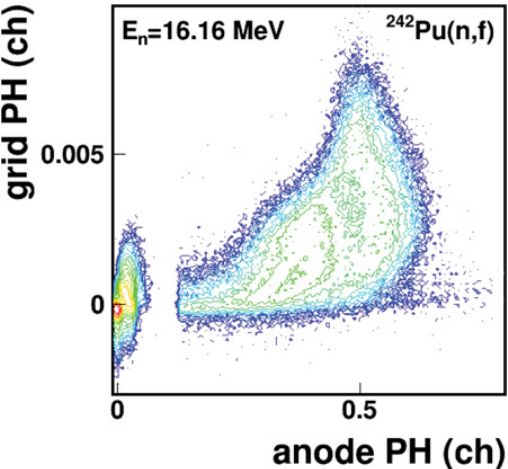
Figure 4. Grid PH versus anode PH data for 242 Pu(n,f) at E n = 16.16